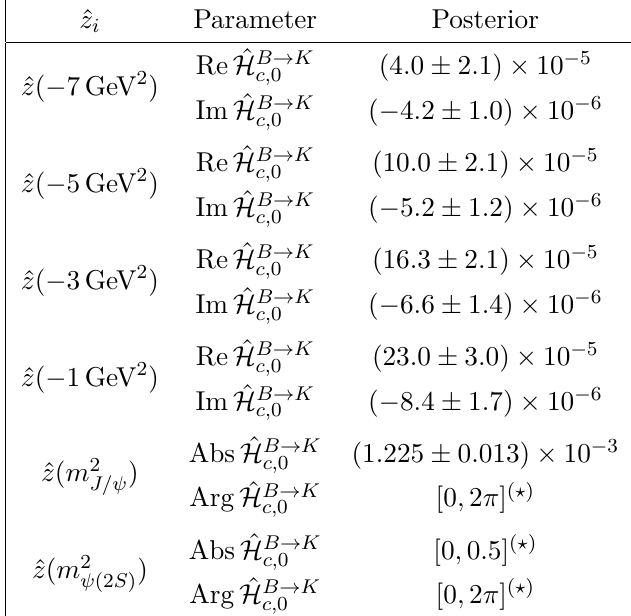
Table 6 . Posteriors of the B → K non-local FFs fit. The ranges of the parameters that are not constrained in the fit are marked with a star ( ? ) . These large ranges contain more than 99% of the posterior probability. They are suggested by the authors to reproduce the results of this work, as described in the text. The multinormal distribution describing the constrained parameters is given in the ancillary file BToK-hatH.yaml .